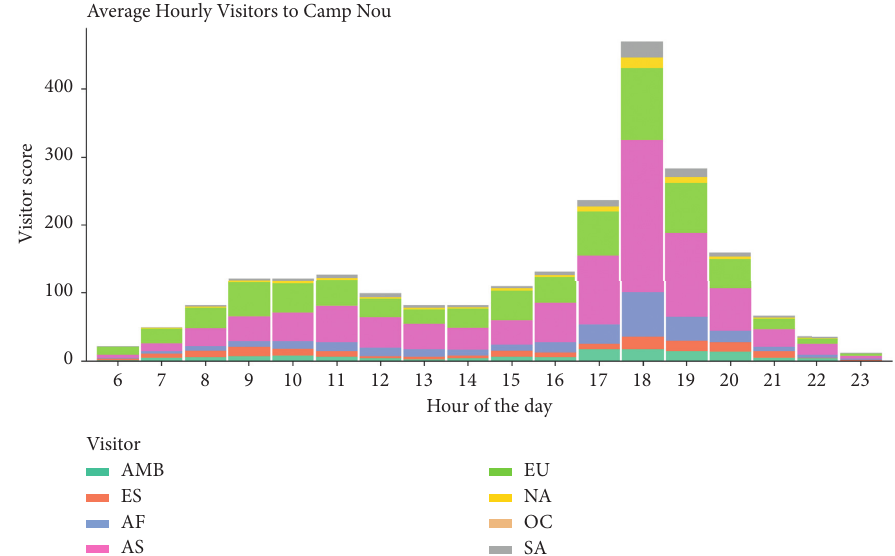
Figure 6: Distribution of visitors at Camp Nou according to their origin and time of the day. AMB: metropolitan area of Barcelona, ES: rest of Spain, AF: Africa, AS: Asia, EU: rest of Europe, NA: North America, OC: Oceania, and SA: South